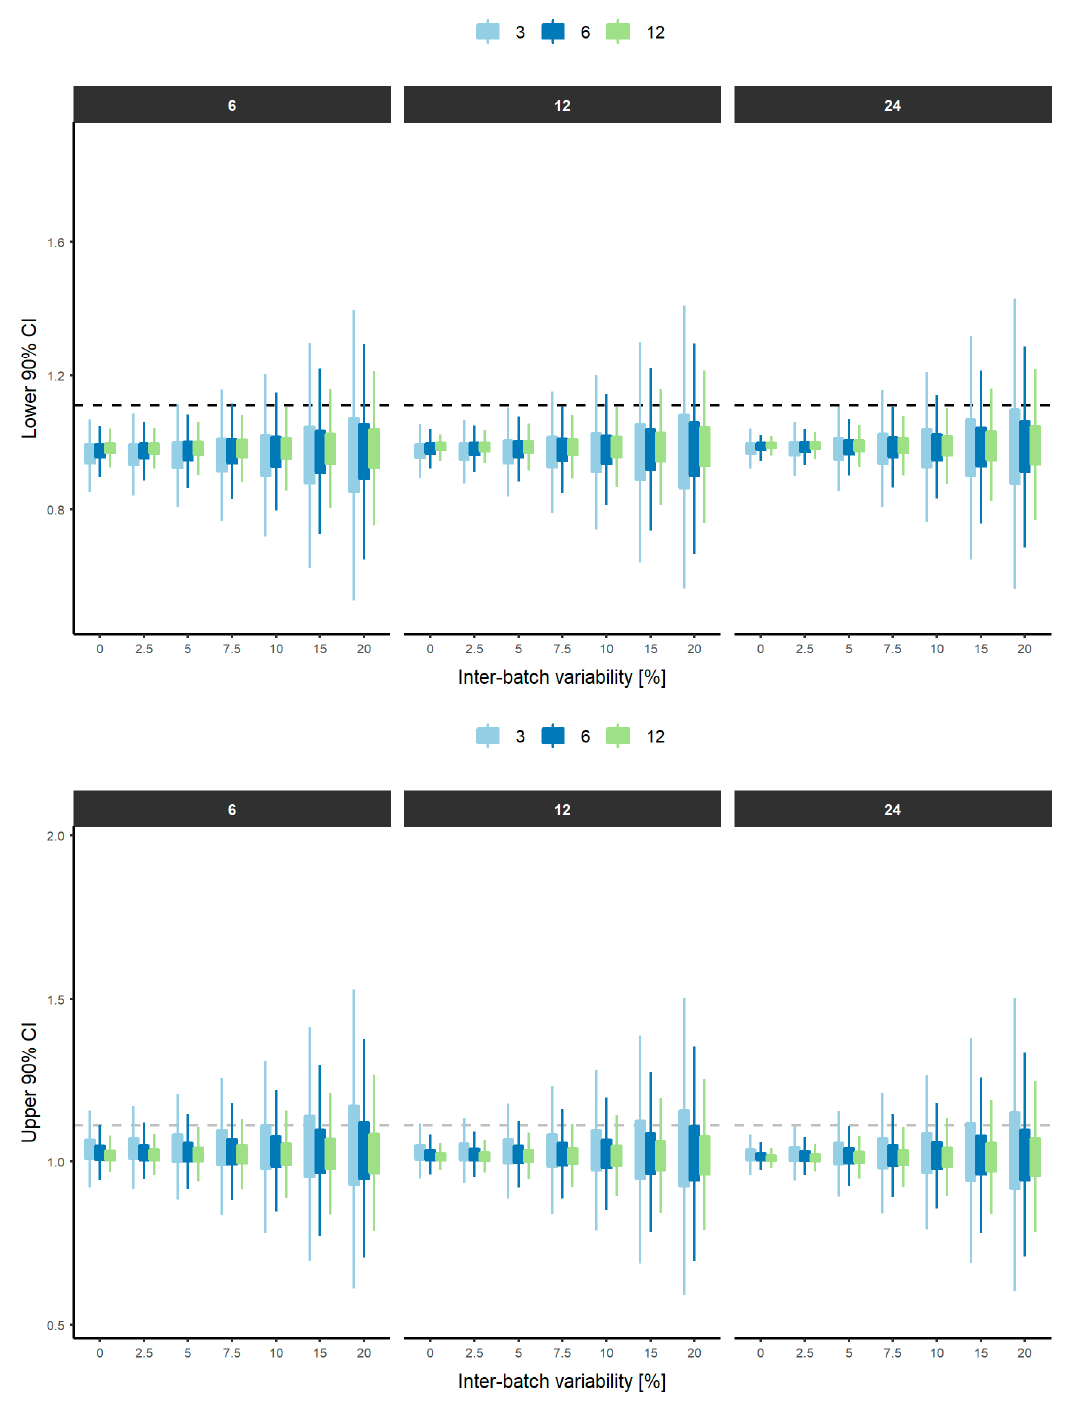
Figure 4. Distribution of the lower ( top ) and upper ( bottom ) 90% confidence intervals from each experiment ( n = 1000), stratified by the number of units (top) when the T/R ratio is 100%. Light blue, blue and green boxplots represent the lower and upper 90% CI when 3, 6 and 12 batches were considered, respectively. The box represents the interquartile range (IQR: Q1–Q3) and lines represent 1.5*IQR. Dashed grey lines represent the lower (0.9) and upper (1.11) limit of the regulatory acceptance range.